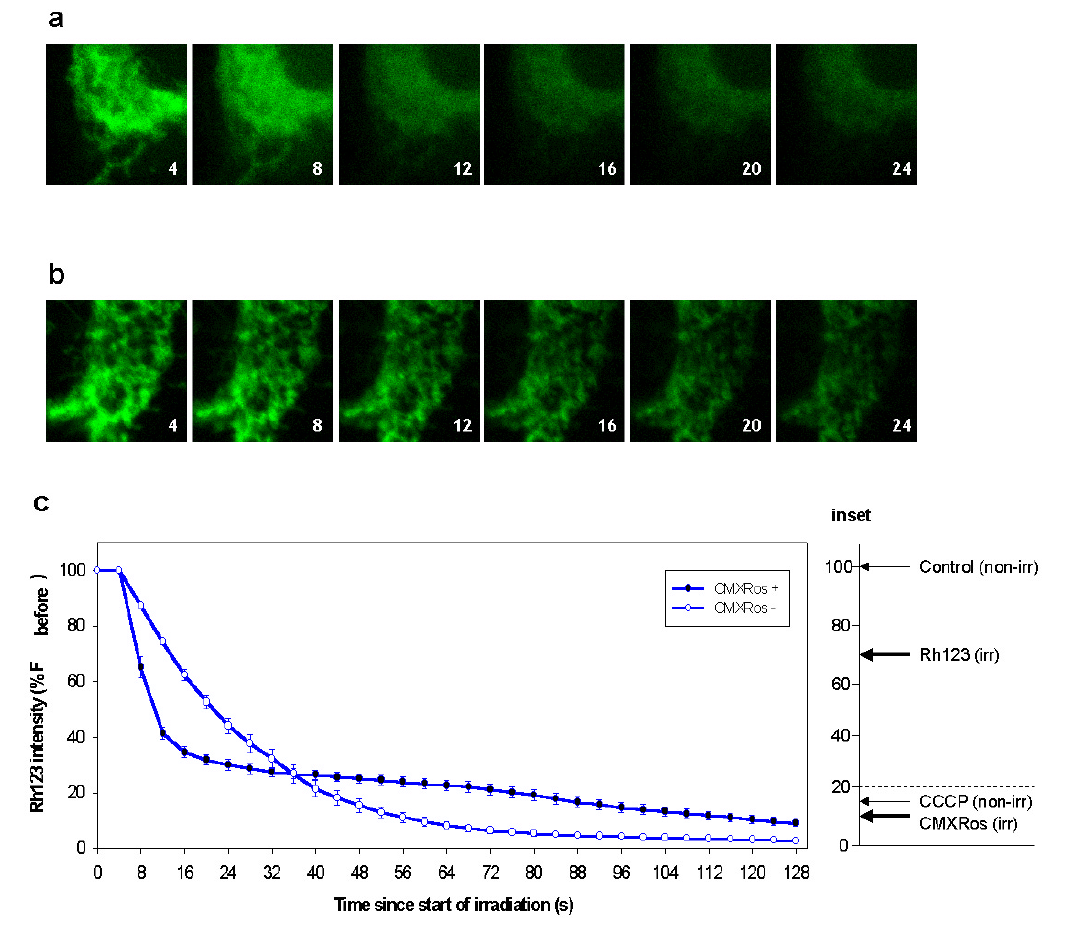
FIGURE 2 . Changes in ∆Ψ m during microscopic photosensitization under various conditions. Cells were imaged at different times during a 128 s series of intensive laser scans. (a) Confocal images showing loss of Rh123 fluorescence in irradiated mitochondria of a cell partially irradiated at the lower half. The cell was loaded with CMXRos (200 nM) and Rh123 (10 µ M) prior to irradiation. (b) Rh123 fluorescence images of irradiated mitochondria in a cell loaded with only Rh123. (c) Quantification of the progressive loss of Rh123 fluorescence intensity in irradiated mitochondria of cells following laser irradiation. Control cells (to indicate loss of Rh123 due to photobleaching) were loaded with only Rh123 (n = 10). Other cells were loaded with Rh123 and CMXRos (n = 10). A region of interest in irradiated mitochondria from each cell was selected to determine the fluorescence intensity of Rh123 in pixel units. Rh123 intensity changes for each cell were obtained from stack images accumulated from the whole duration of irradiation, each image collected at every 4 s for a total of 128 s. The mean fluorescence intensity (pixel units ± S.E.M.) of Rh123 for each cell category at each time point was obtained by averaging the value obtained in 10 cells and expressed as a percentage of the initial fluorescence intensity (F before ). The inset (thick arrows) indicates Rh123 retention values in nonirradiated mitochondria of cells immediately after partial irradiation (irr) at 128 s or in all mitochondria of cells not irradiated (non-irr). Fluorescence values were 68% ± 5% (n = 13) for Rh123 alone or 11% ± 4% (n = 9) for Rh123 plus CMXRos. Control cells, loaded with Rh123 but not photoirradiated, were either further untreated or treated with CCCP (to indicate high or low ∆Ψ m , respectively). Fluorescence values were 100% ± 0% (n = 20) or 14% ± 2% (n = 15), respectively), thin arrows in inset. Dashed line represents the cutoff point for scoring cells either retaining (above line) or losing (below line) ∆Ψ m in nonirradiated mitochondria after partial irradiation (as used in Fig.